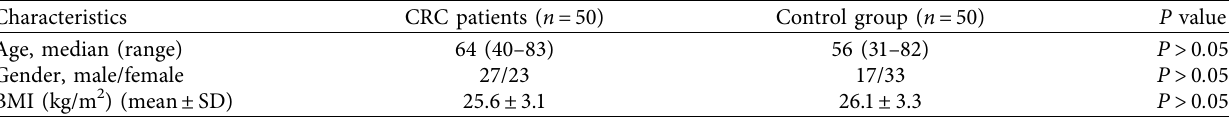
Table 1: Characteristics of CRC patients and control group